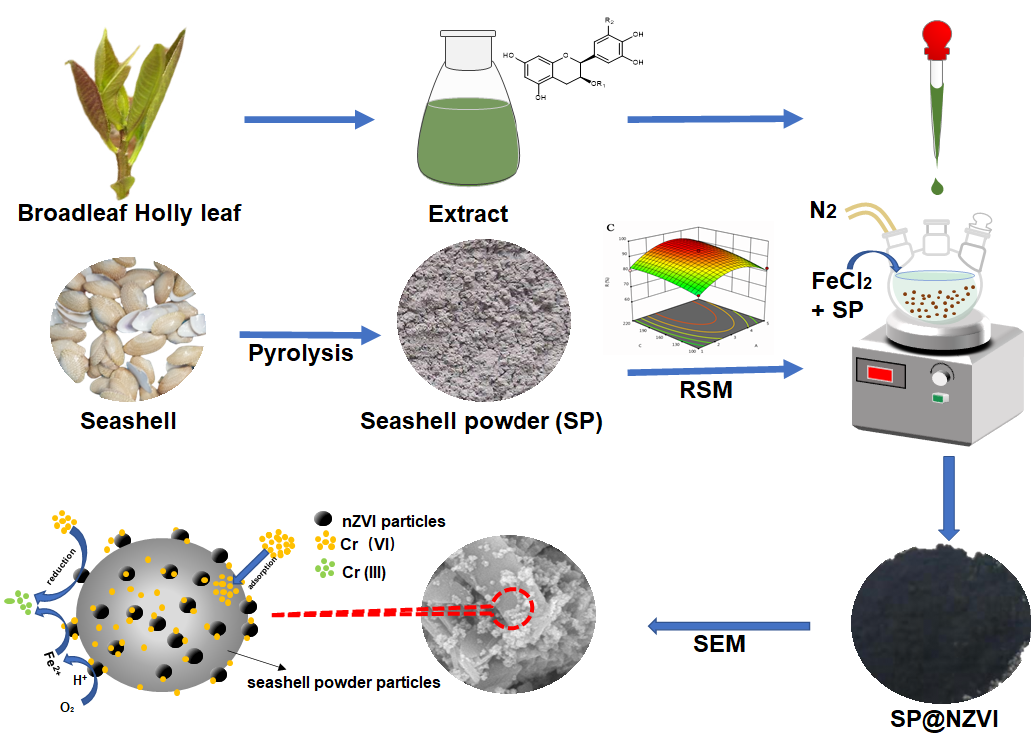
Figure 1. Proposed scheme for green synthesis of SP@nZVI and the related mechanism controlling its reaction with Cr(VI).